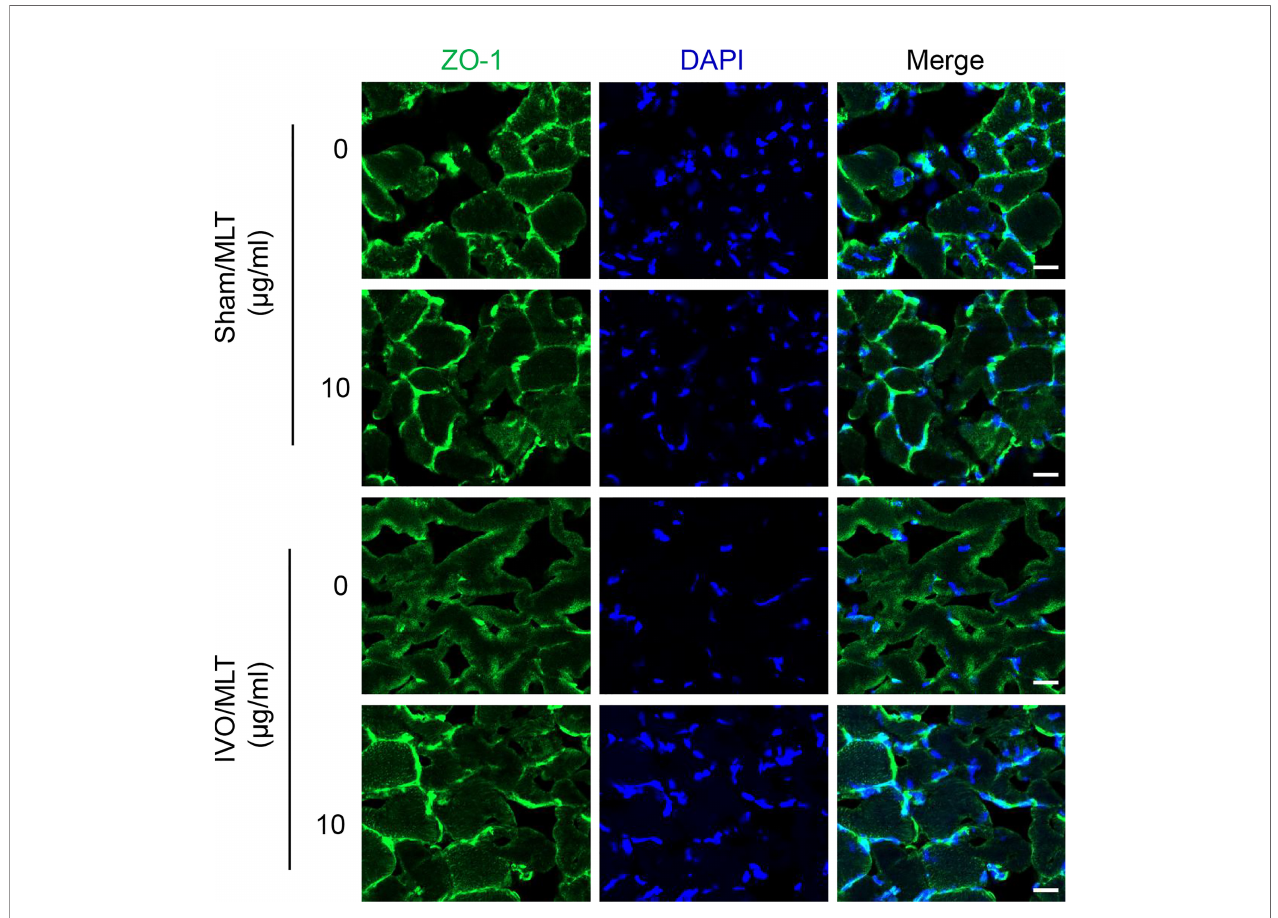
FIGURE 3 | MLT prevents endothelial dysfunction in IVO model. Representative immuno fl uorescence staining images with ZO-1 (green) using gastrocnemius muscle from mice (scale bar: 20 m